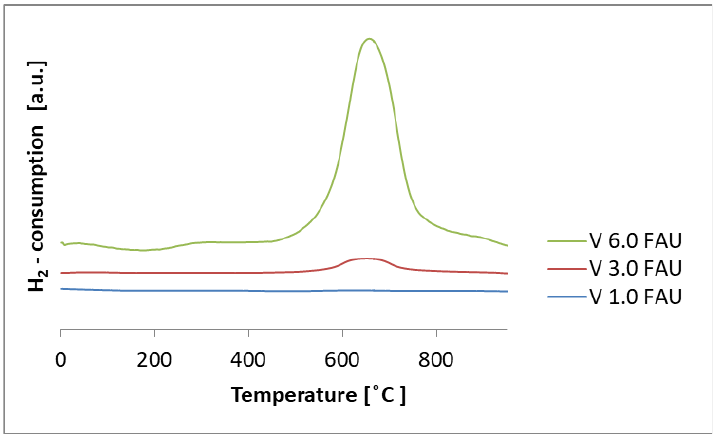
Figure 5. Temperature-programmed reduction with the hydrogen method (H 2 -TPR) profile of the prepared samples.